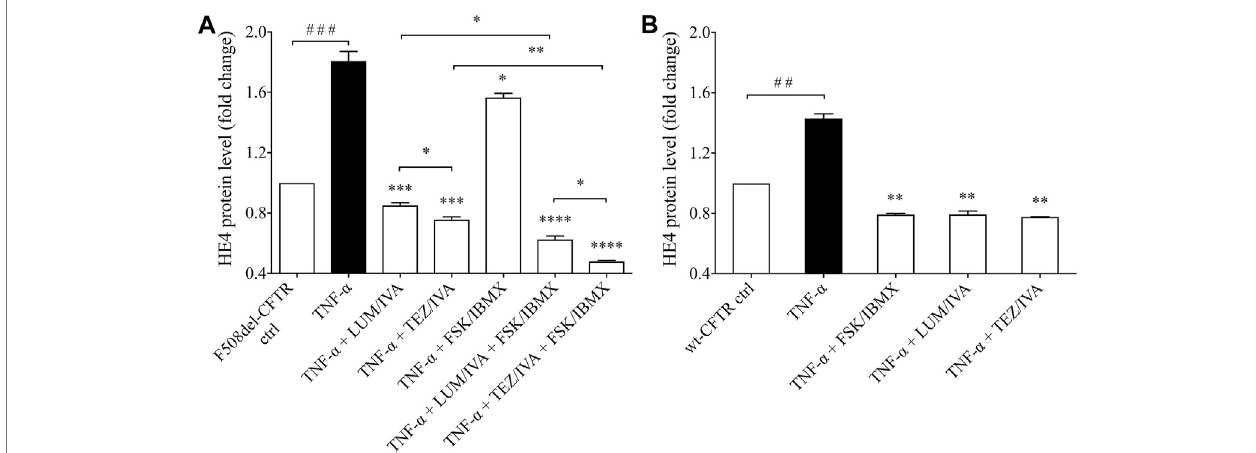
FIGURE6| DeterminationofHE4levelinTNF- α activatedF508del-CFTRorwt-CFTRCFBE41o − cellswith invitro modulatedCFTRfunction.First,TNF- α activated F508del-CFTR CFBE 41o − cells were analyzed under the treatment with LUM/IVA, TEZ/IVA, FSK/IBMX or their combination for 24 h. TNF- α could not elevate HE4 expressioninthepresenceofimprovedCFTRfunction (A) Inparallel,CFTRfunctionwasaffectedbyFSK/IBMXorCFTRmodulatorsinTNF- α -stimulatedwt-CFTRCFBE 41o − cellsfor24 h.SimilartotheresultsinF508del-CFTRCFBE41o − cells, HE4expressionremained loweredcomparedtosampleswithTNF- α but withasmaller extent (B) Mean ± SEM, n (cid:2) 5 – 6 samples/condition. * p < 0.05, ** p < 0.01, *** p < 0.001 and **** p < 0.0001 vs. control samples with TNF- α and DMSO; ## p < 0.01 and ### p < 0.001 vs. control samples with